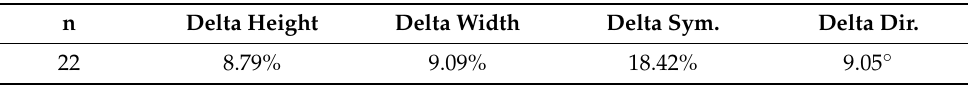
Table 2. Comparison of the manual and automated metrics over Broome area bathymetry.